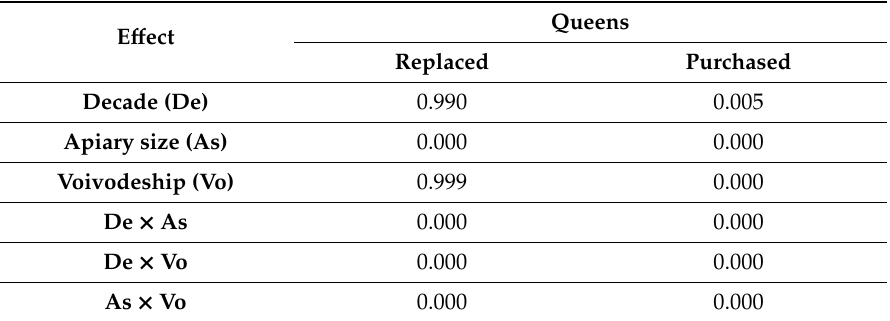
Table 4. Probability of Wald χ 2 test statistic for the tested classification for queens and their interaction in GLMs estimated for investigated dependent variables. Queens E ff ect Replaced Purchased Decade (De) 0.990 0.005 Apiary size (As) 0.000 0.000 Voivodeship (Vo) 0.999 0.000 De × As 0.000 0.000 De × Vo 0.000 0.000 As × Vo 0.000